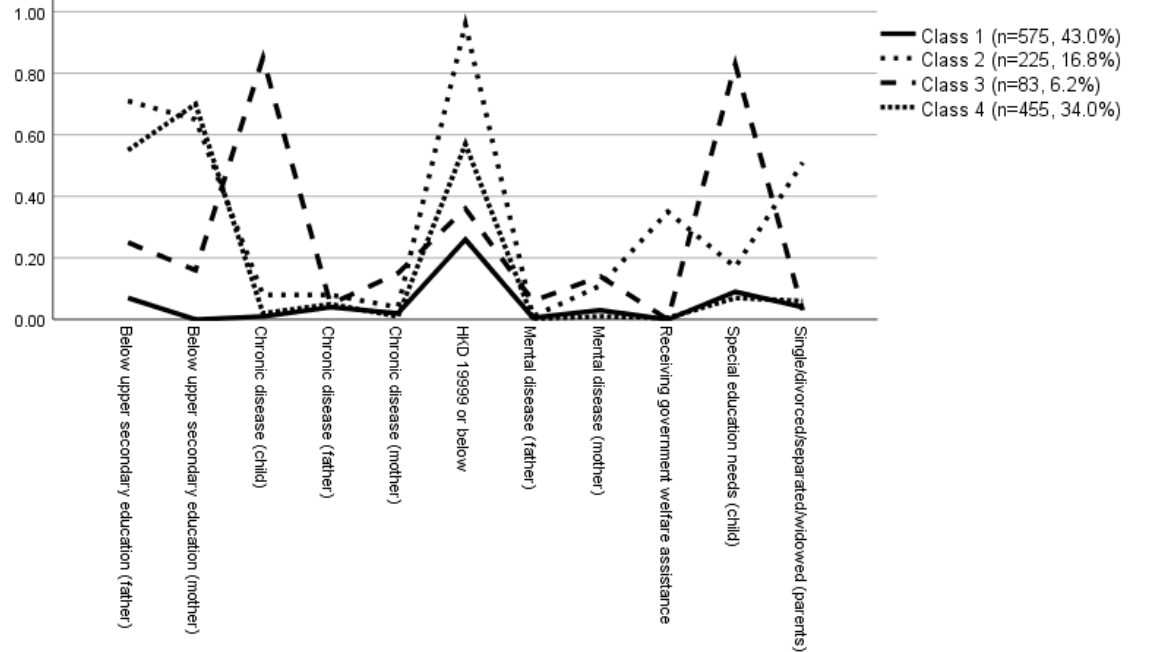
Figure 1. Item-response probabilities for 11 family hardship indicators across the 4 classes (note: Class 1 = Low hardship; Class 2 = Poverty; Class 3 = Poor health; Class 4 = Low income).